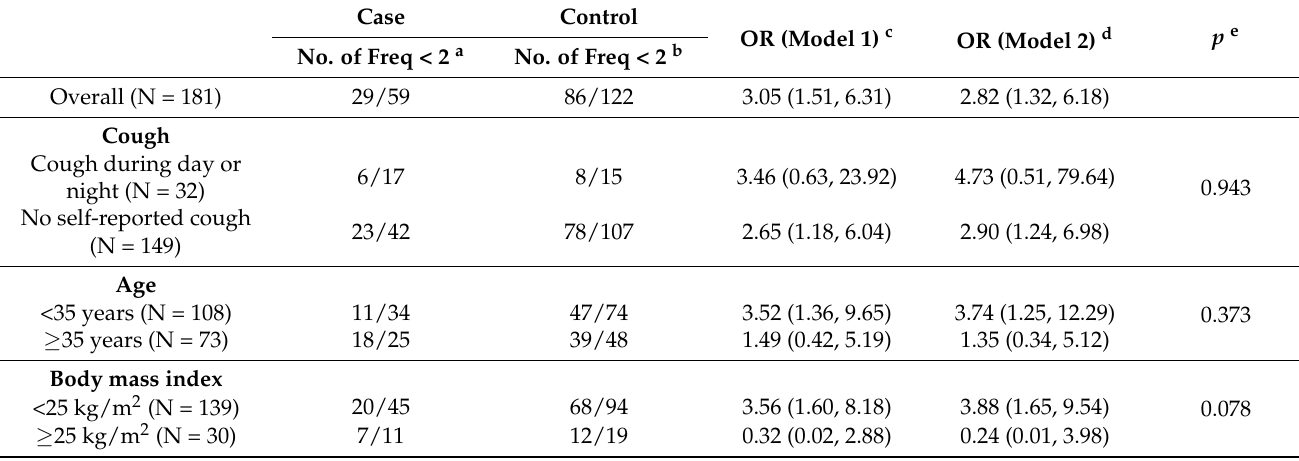
Table 3. Odds ratio for self-reported cough, age group or body mass index of those with miscarriage with a house cleansing of lower than twice per